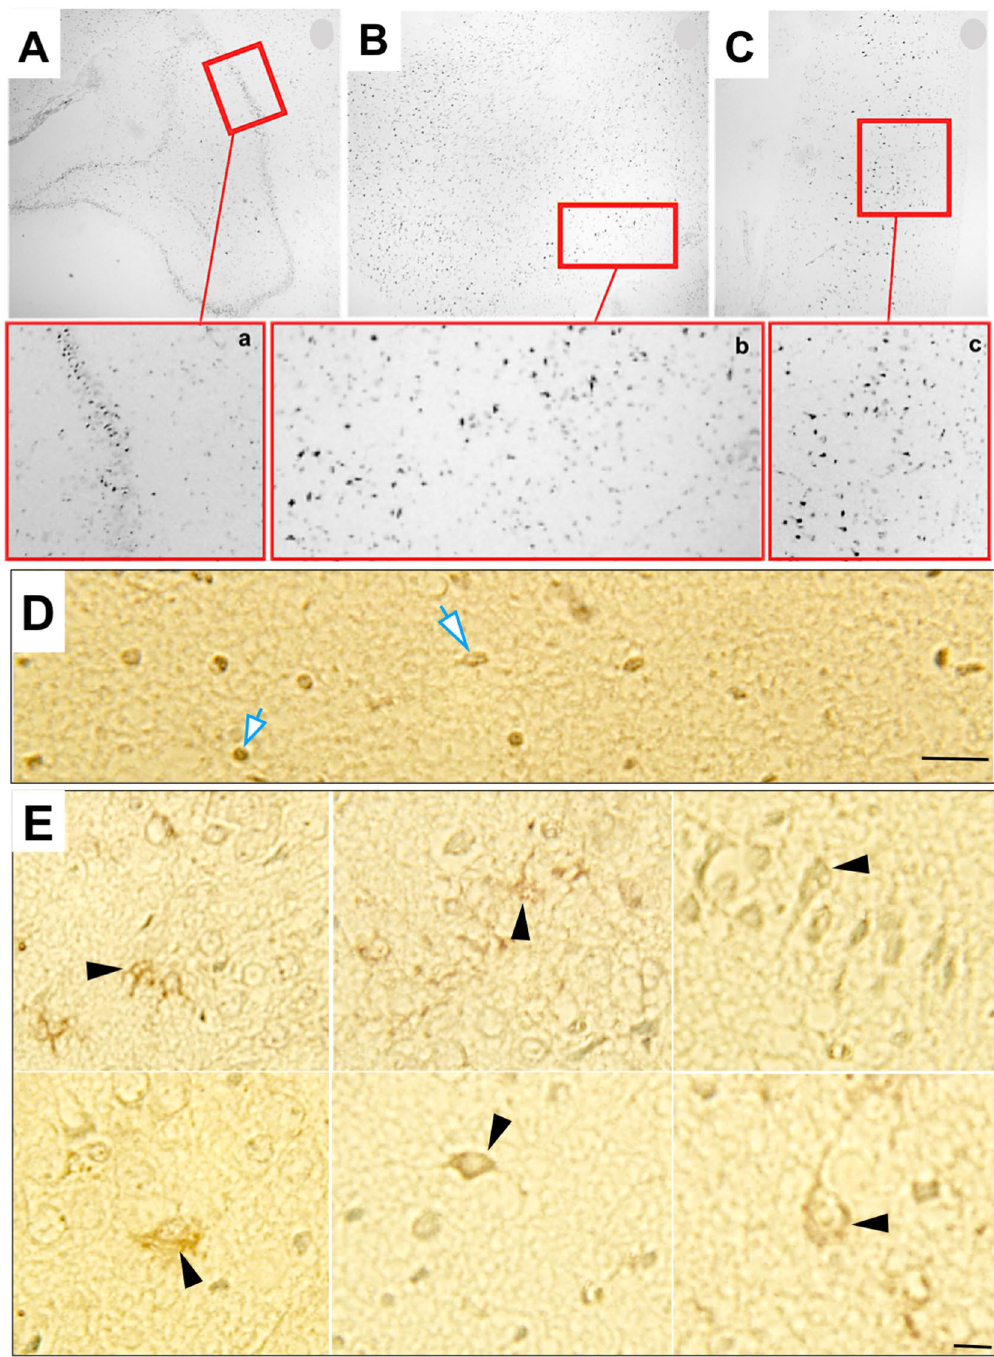
Figure 1. CD40 expression in human Temporal Lobe Epilepsy (TLE): ( A – C ) Representative microphotographs from a histological section of human hippocampal regions at low magnification. Inside the red boxes, dentate gyrus (DG) ( A ) and CA3 ( B,C ) from a patient with TLE are present which had been magnified below. These figures depict cellular dispersion and loss of neurons ( A ), disruption of cellular alignment, and loss of neurons ( B,C ). These pathological features are representative of TLE type I- II. ( a–c ) represent magnification of ( A – C ). ( D–E ) Representative cellular CD40 IR in TLE. Bar: 100